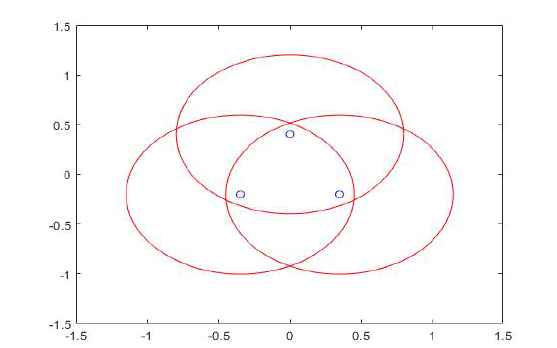
Figure 2. The Matlab solution of the workspace of 3RRR planar Parallel